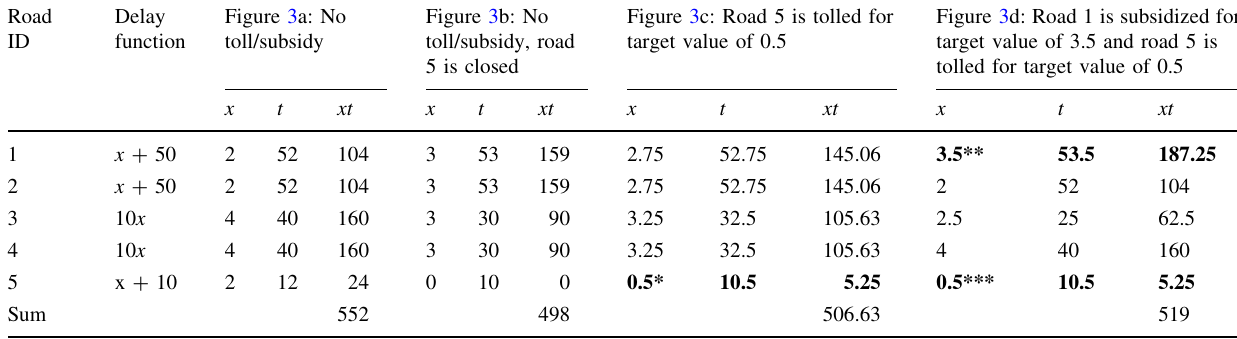
Table 1 Braess example, different too/subsidy scenarios Road Delay Figure 3a: No ID function toll/subsidy